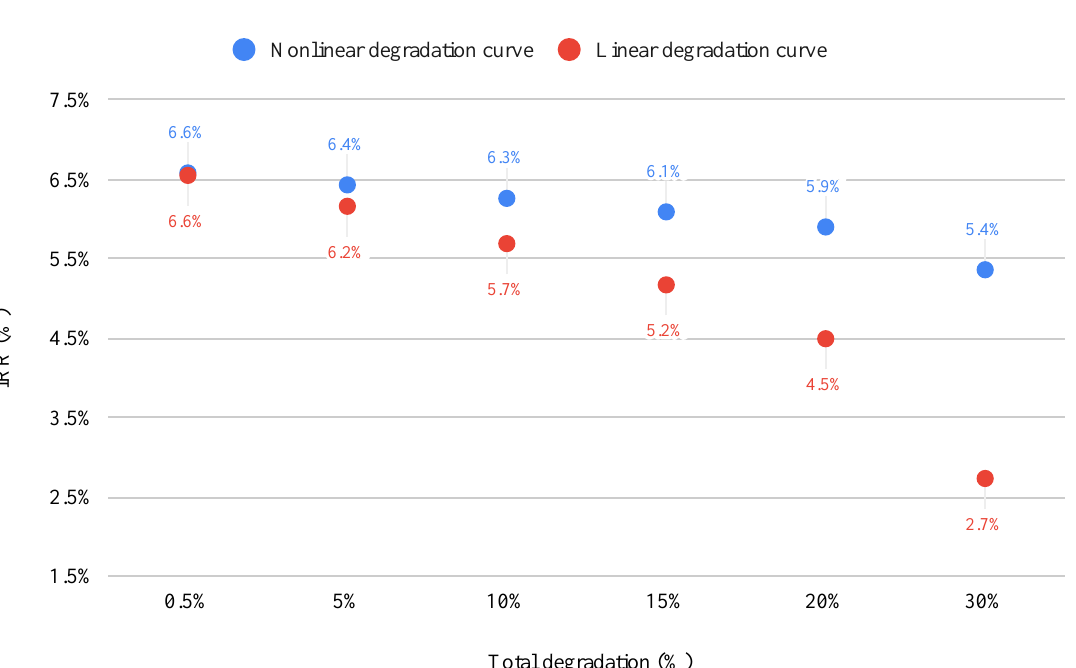
Table S2. (a) FIT schedule from 2012 to 2020 (b) Investment cost from 2012 to